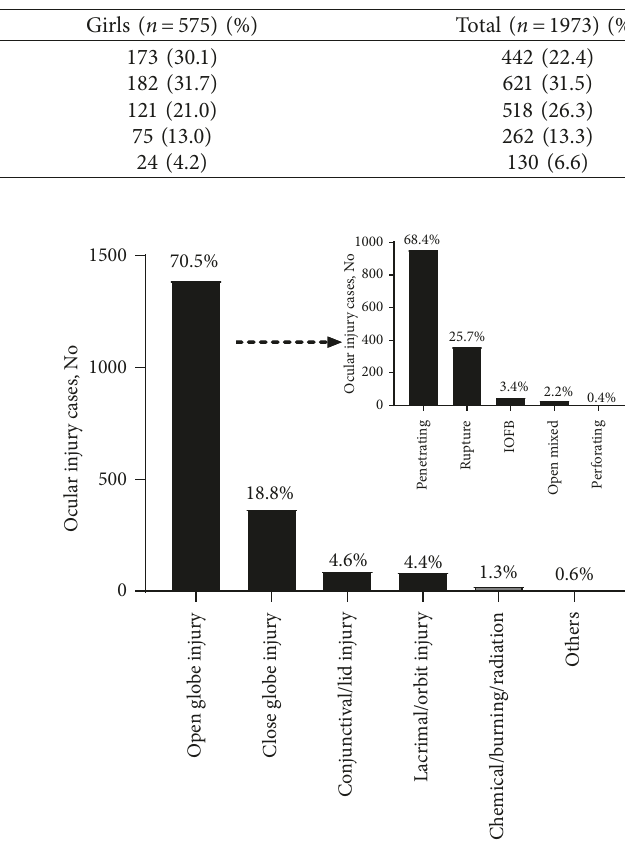
Figure 1: Proportion of pediatric eye trauma cases among all injured patients in different geographical regions in China. Table 2: Gender distribution of trauma cases in different age groups from 2019 to 2020.